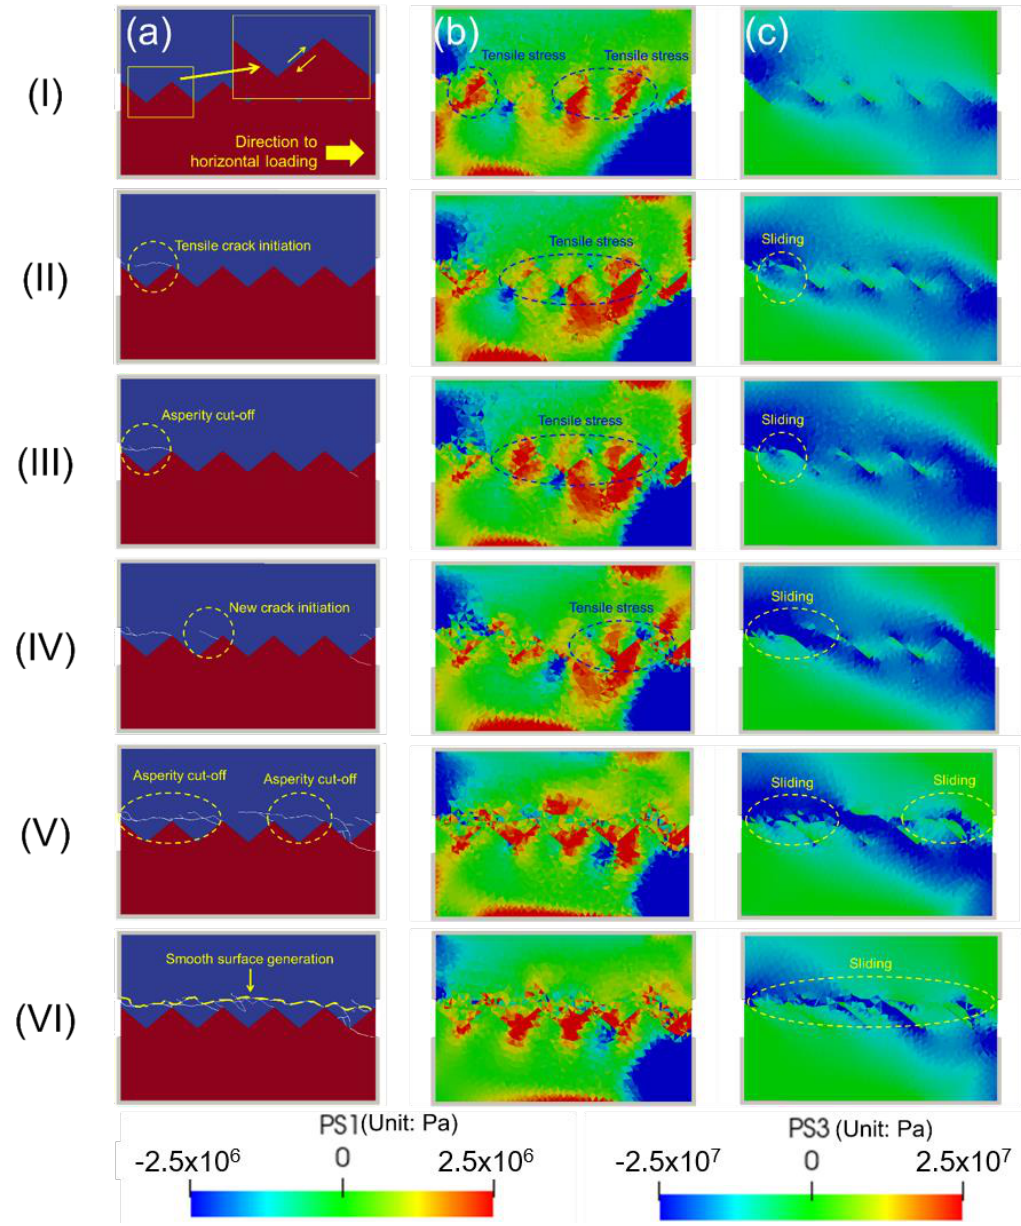
Figure 11. The simulated fracture process in the shear test with the rough concrete–rock joint with an asperity angle α = 40 degrees. ( a ) Temporal change of distribution of maximum principal stress (PS1), ( b ) Temporal change of distribution of minimum principal stress (PS3), ( c ) The fracture process showing the development of macroscopic fracture surfaces.